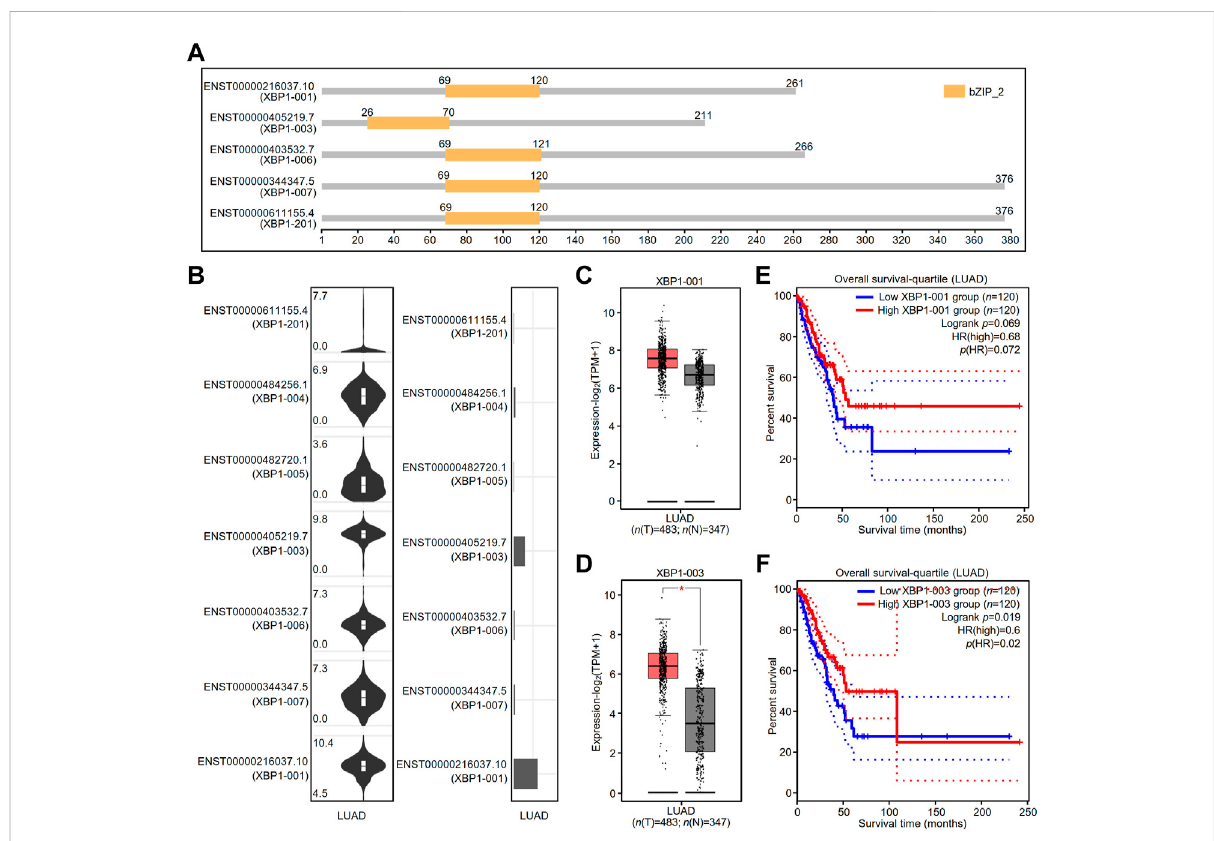
FIGURE 6 The expression and prognostic value of XBP1 isoforms in LUAD. (A) XBP1 isoforms and the plot for their protein domain structures. (B) The expression distribution(violinplot) andisoform usage (barplot)ofXBP1inLUAD. (C,D) The expression ofXBP1isoforms XBP1-001 (C) andXBP1-003 (D) in LUAD. (* p < 0.05) (E,F) The prognostic value for overall survival of LUAD patients of XBP1 isoforms XBP1-001 (E) and XBP1-003 (F)